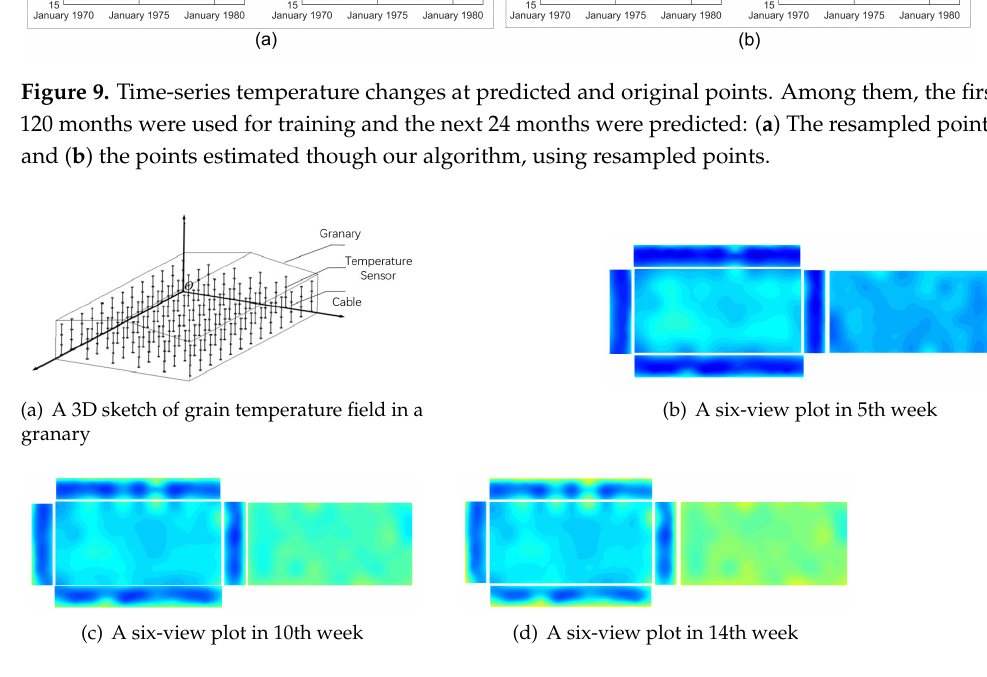
Figure 10. Analysis of grain temperature through our algorithm: ( a ) Distribution of sensors in the grain storage silo; ( b , c ), the first 12 weeks were sampled data for gradual fitting; and ( d ) prediction at the 14th